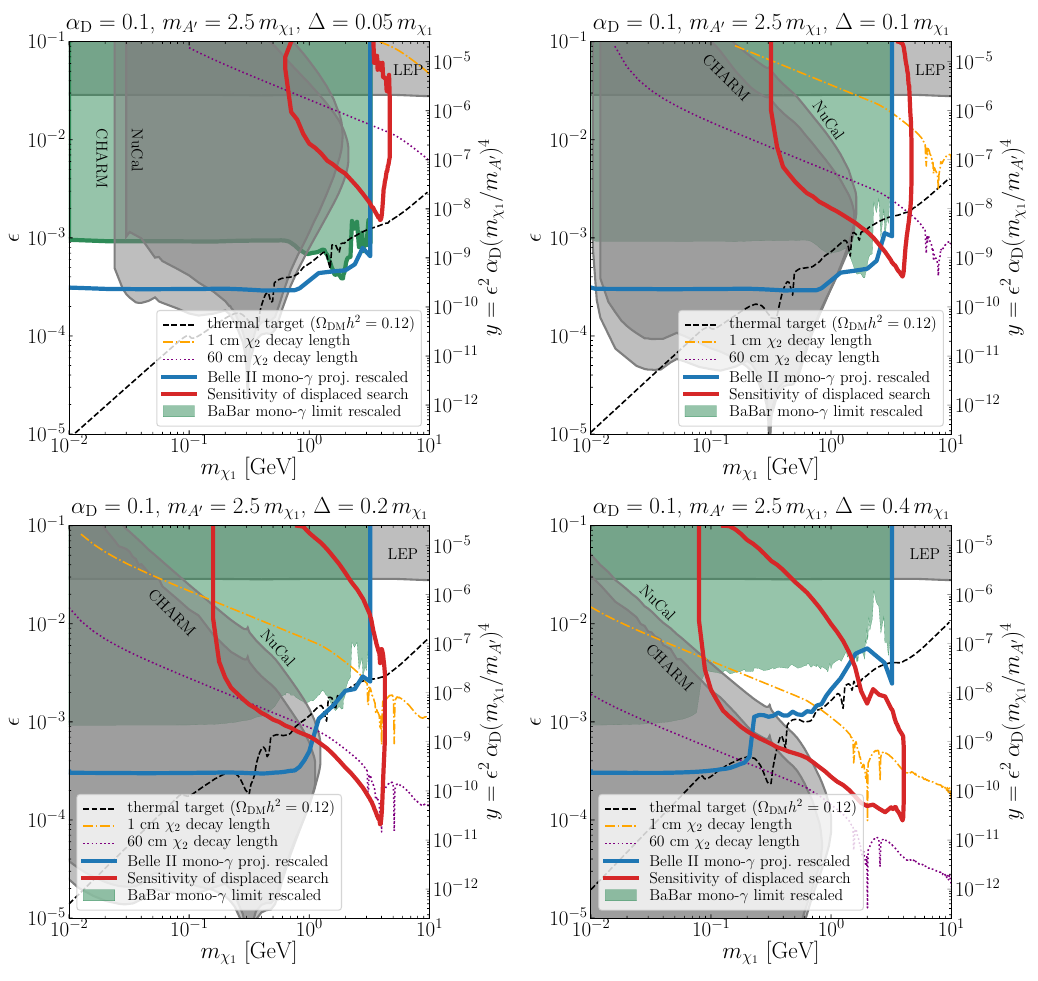
Figure 6 . Sensitivity of Belle II to the parameter space of inelastic DM for an integrated luminosity of 20 fb (cid:0) 1 for m A = 2 : 5 m (cid:31) 1 0